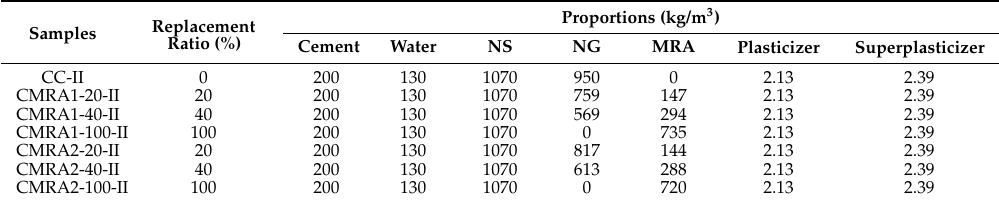
Table 5. Composition of the concrete mixes for Series II (200 kg of cement/m 3 ).